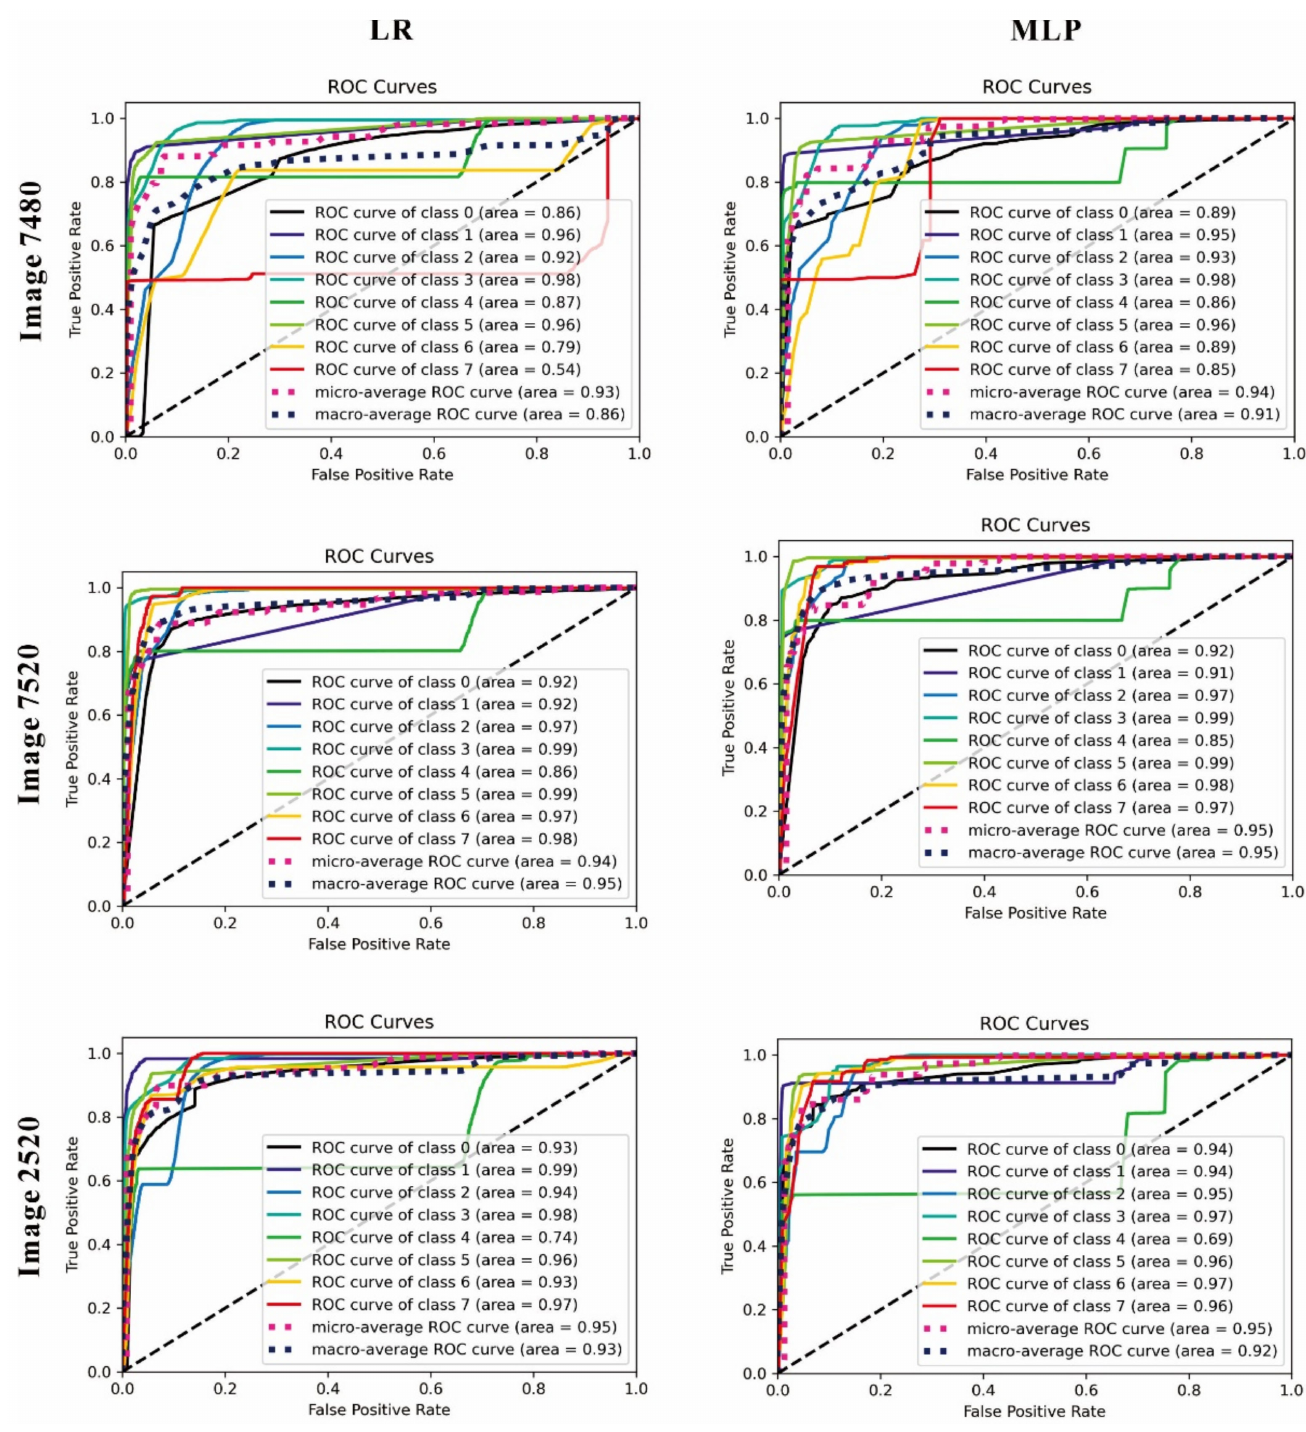
Figure 16. ROC-AUC analysis of LR and MLP classifiers in case